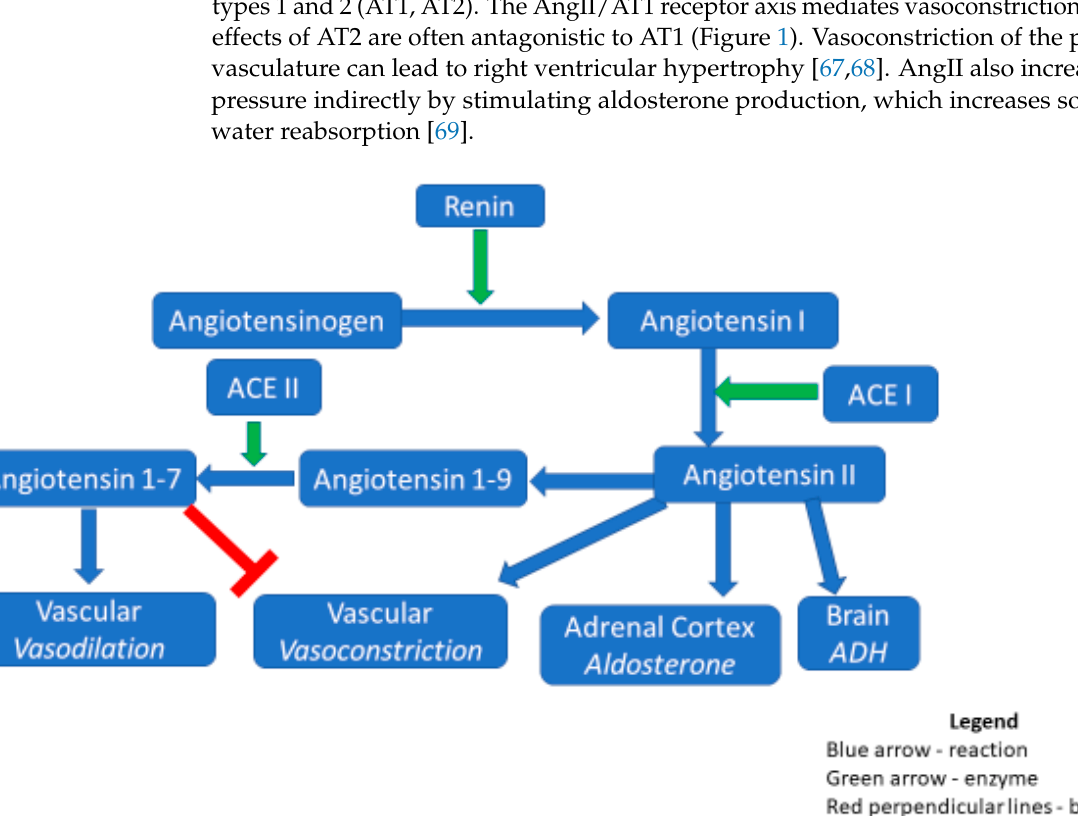
Figure 1. Renin–angiotensin-aldosterone system (RAS) and ACE inhibitors. The precursor molecule angiotensinogen is cleaved by renin to form angiotensin 1 in response to low sodium-chloride, as sensed by the macula densa. Angiotensin 1 is then further modified by the angiotensin-converting enzyme (ACE) to form angiotensin II. The ACE is the target of ACE inhibitors. Angiotensin II has direct effects on the vasculature, adrenal cortex, and brain, causing vasoconstriction and the secretion of aldosterone and the anti-diuretic hormone (ADH), respectively. An alternate pathway also exists, whereby angiotensin II is converted to angiotensins 1–9 and then angiotensins 1–7. A key enzyme in the formation of the latter is ACE2. Angiotensins 1–7, in contrast to angiotensin II, cause vasodilation and inhibit